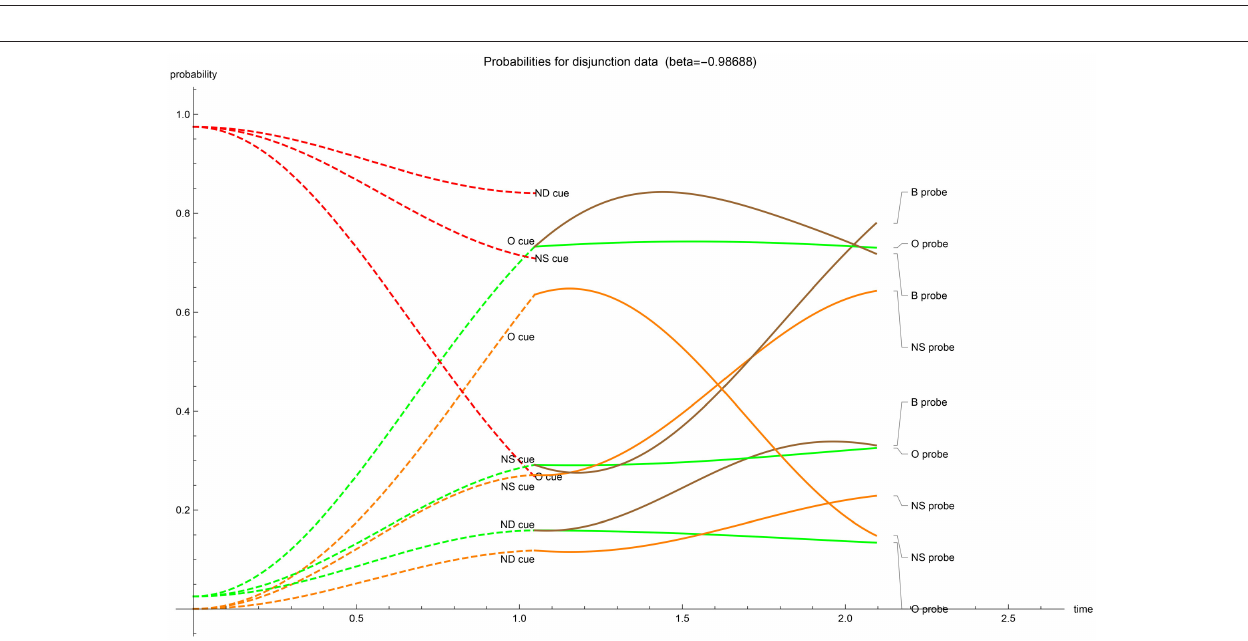
FIGURE 2 | β < 0 case: temporal evolution of acceptance probabilities for the EOD-disjunction paradigm [3]. Red indicates N probability component, orange indicates G probability component while green indicates V G probability component. In the second stage brown indicates the acceptance probability for the b ? + G ). Notice the near absence of gist in the initial probe ( V +